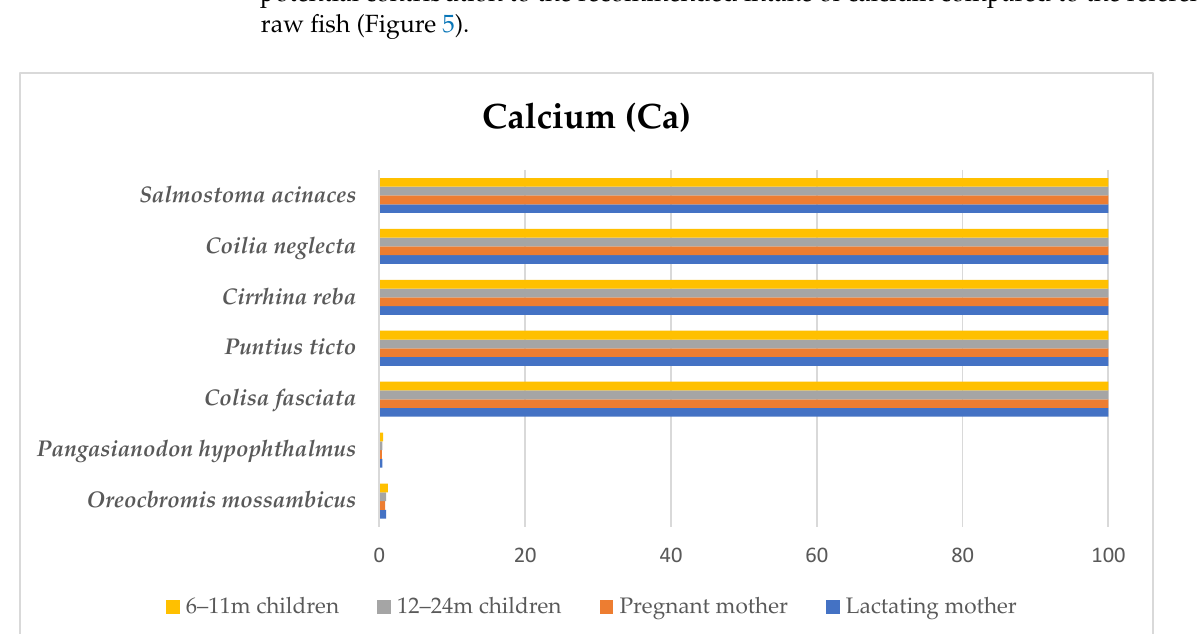
10 of 18 Figure 4. Potential contribution (%) of dry fish to the RNI of zinc for children and pregnant and lactating women in Bangladesh. Local names: Tengra ( Mystus tengra ), Kata mach ( Osteogeniosus militaris ), Lakhua ( Polynemus indicus ), Kachki ( Amblypharringodon microlepin ), Rita ( Rit rita ), Thai